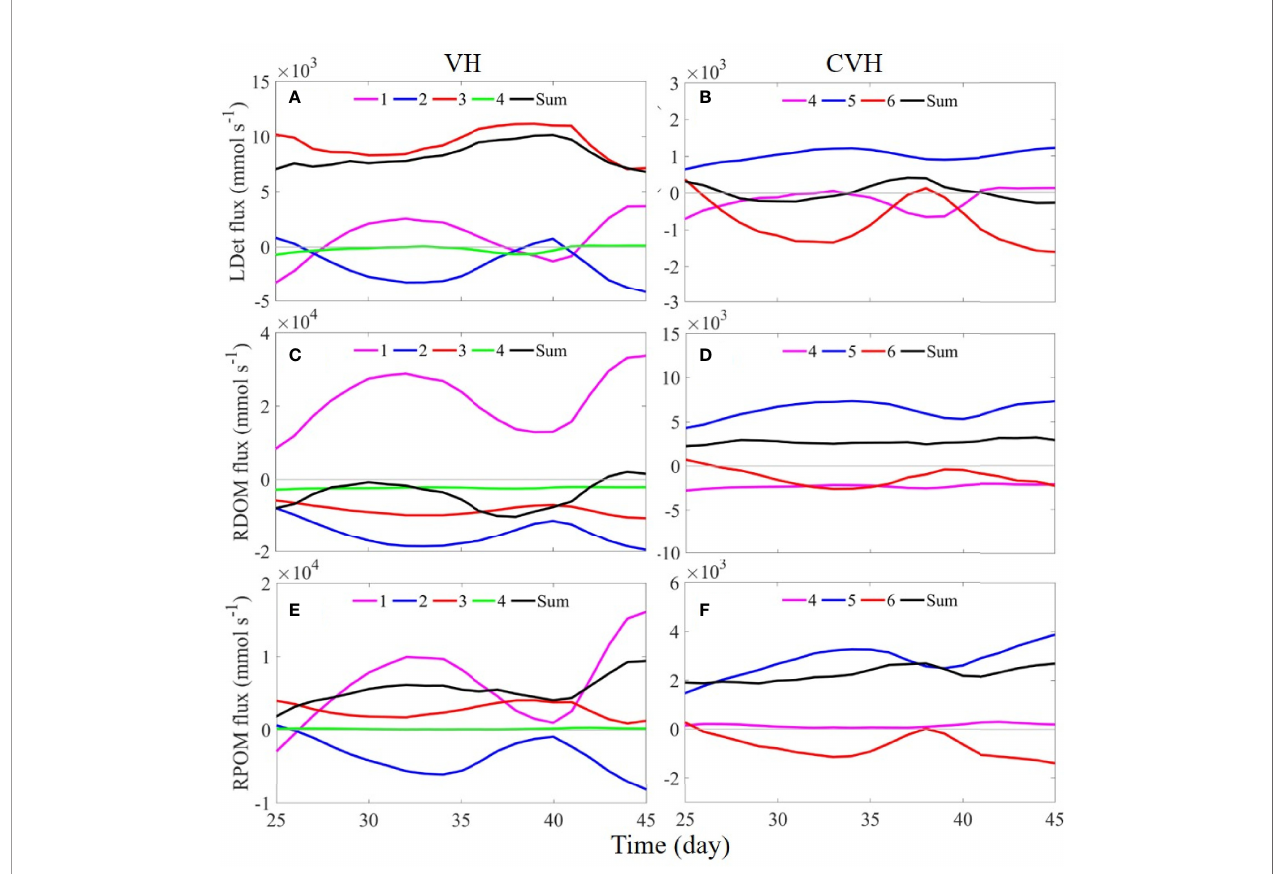
FIGURE 8 | Time-series of (A, B) LDet, (C, D) RDOM, and (E, F) RPOM fl uxes through sections 1 – 4 of the VH (left column) and through sections 4 – 6 of the CVH (right column). Positive and negative values represent fl ux into and out of the VH/CVH. Note that the scales used from CVH are smaller in the fi